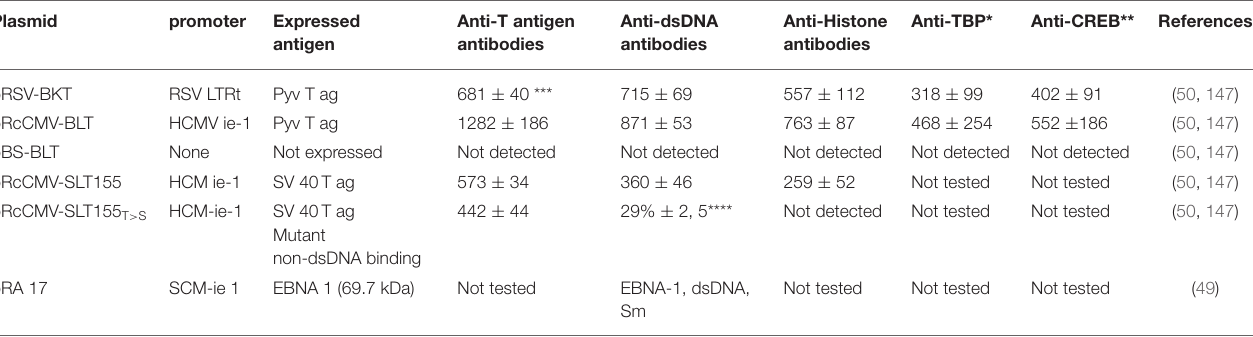
TABLE 2 | Experimental expression of single viral DNA-binding proteins in context of plasmid injections, promote production of anti-dsDNA antibodies and to a variety of chromatin proteins.